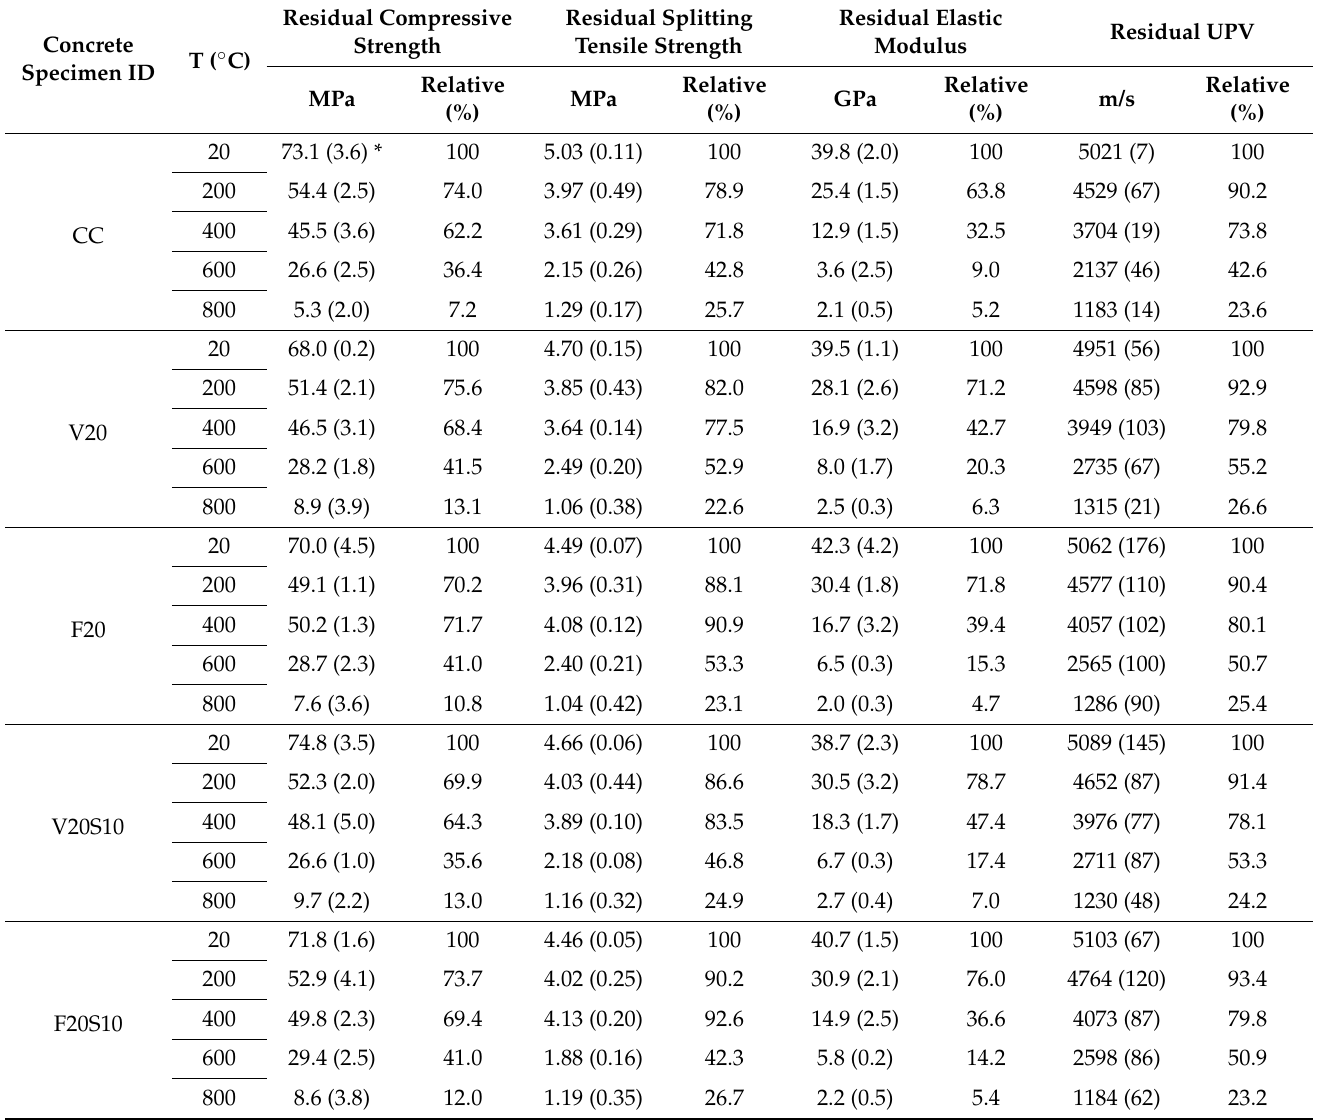
Table 6. Residual mechanical properties of concrete after exposure to elevated